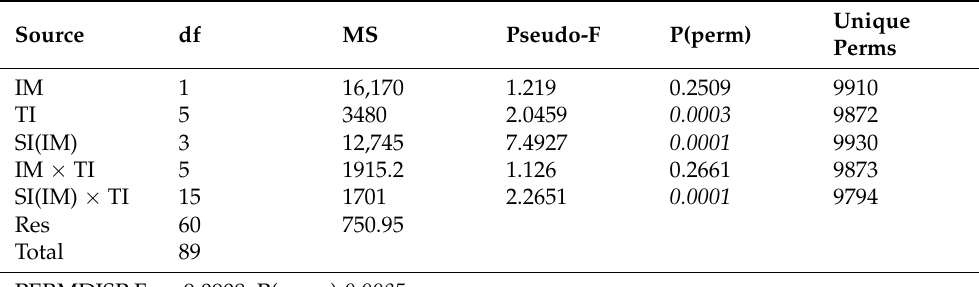
Table 5. The table shows PERMANOVA. Analysis of spatial-temporal variation in hard-bottom polychaete assemblages in the study area IM, impact; SI, site; TI, time. Significant p -values are given in italics. MS, mean squares; Pseudo-F, statistic; P(perm) probability calculated by permutations; unique perms, unique permutations. Data square-root transformed. 9999 permutations were used. Unique Source df MS Pseudo-F P(perm) Perms IM 1 16,170 1.219 0.2509 9910 TI 5 3480 2.0459 0.0003 9872 1915.2 SI(IM) × TI 750.95